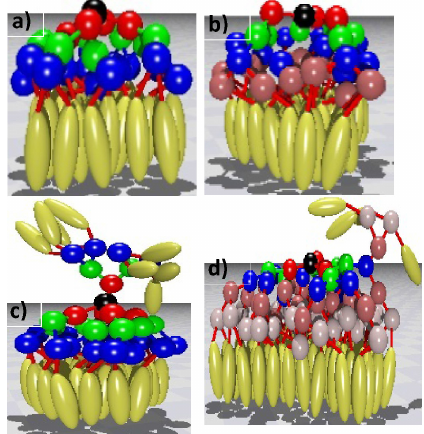
D D D ; ( b ) G ; ( c ) G ; and ( d ) G 3 4 4 3 3 5